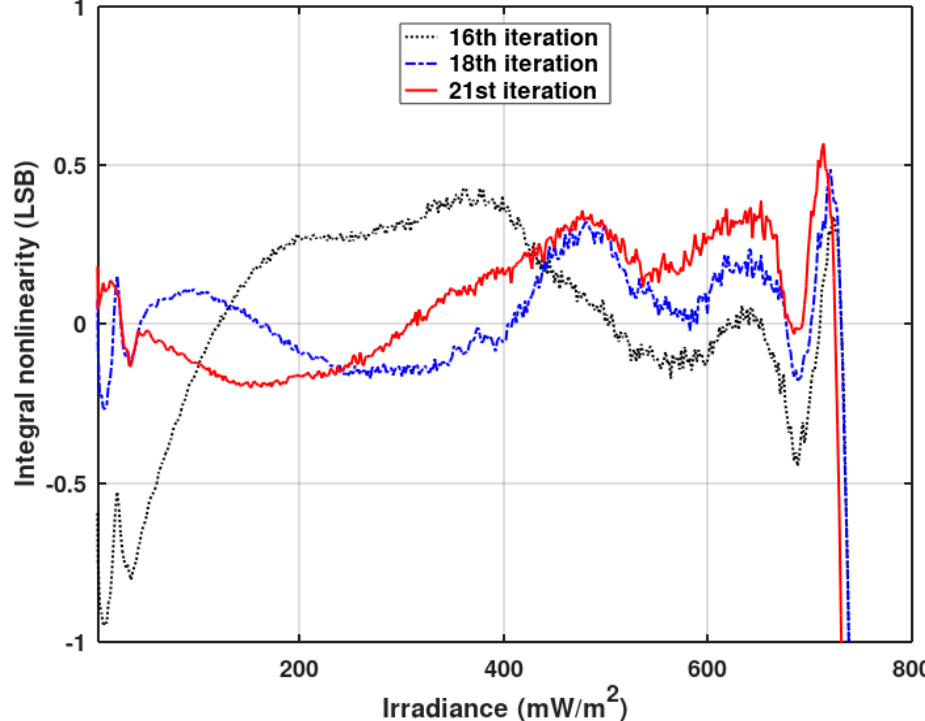
Figure 14. The results of the final iterations of the linearity correction (with the gain and offset correction disabled). The measured INL is an average of 128 pixels.